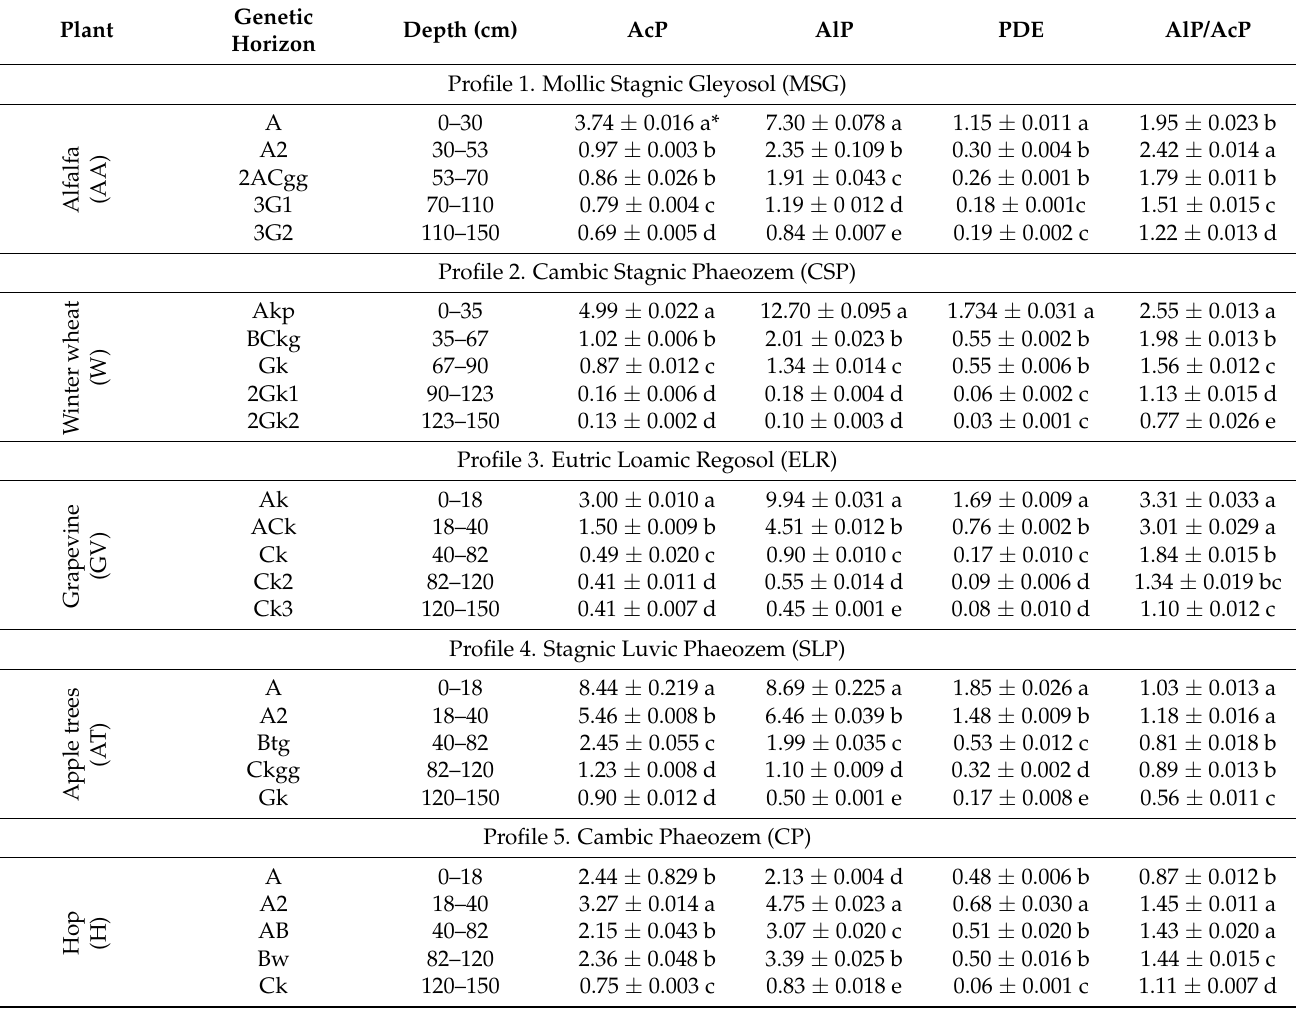
Table 4. Depth-related changes in the activities of P transforming enzymes; mean ( ± SE), n = 5.